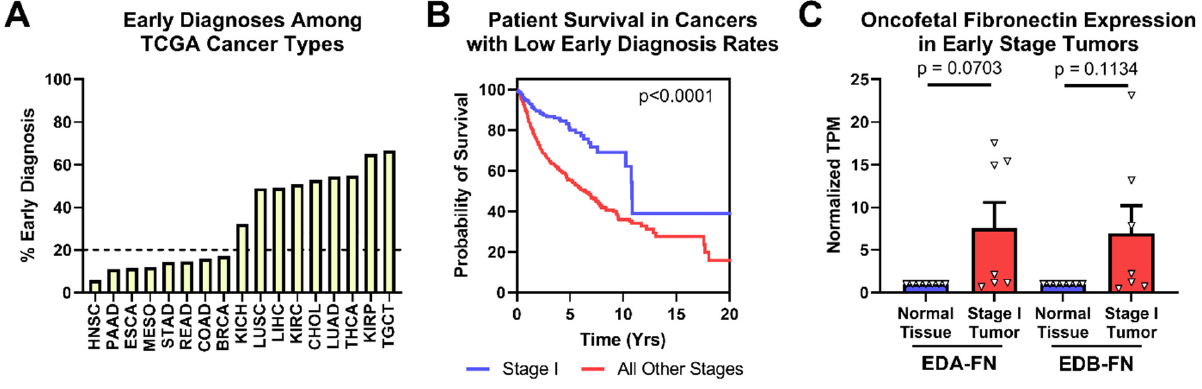
Figure 5. Oncofetal FN expression and early-stage diagnosis. ( A ) Percentage of patients diagnosed at stage I by cancer type. ( B ) Pan-cancer Kaplan–Meier survival curves of stage I patients ( n = 363) compared to those diagnosed at all other stages ( n = 2273) for cancer types with less than 20% of early-stage diagnosis. ( C ) Oncofetal FN expression in stage I tumors compared to corresponding normal tissue expression ( n = 7). Cancer types were excluded from analysis if the number of normal tissue or stage I tumor samples was fewer than 10.